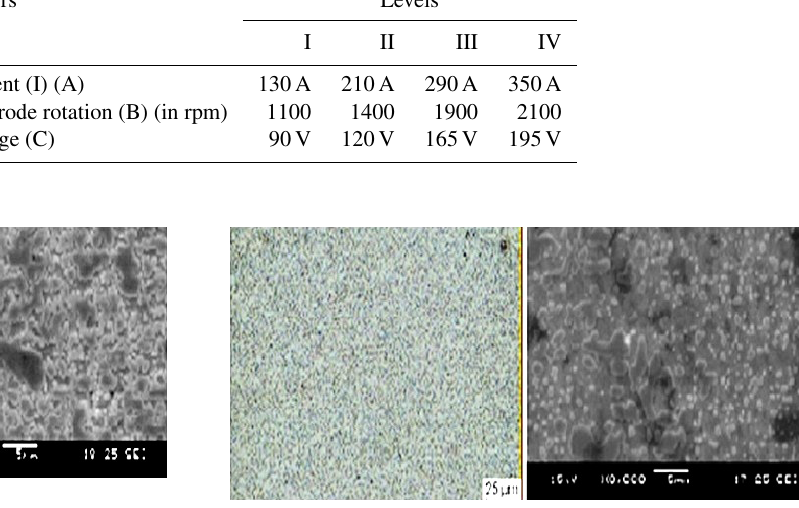
Figure 3. Untreated and treated electrode microstructure.